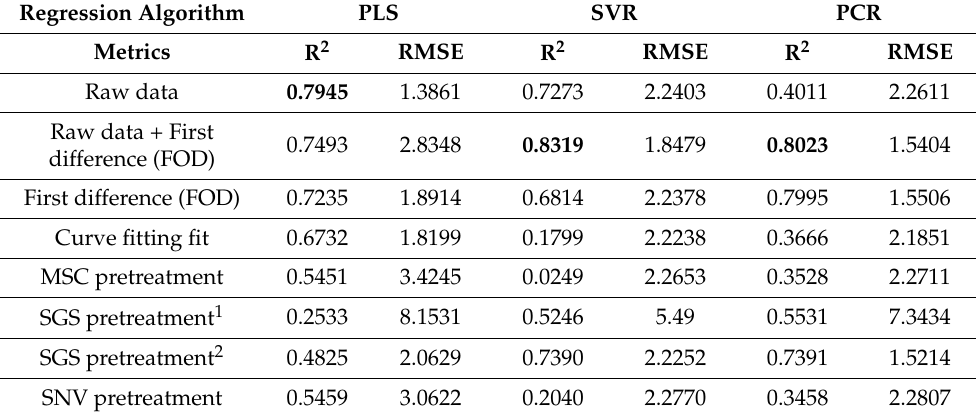
Table 1. Comparison of hyperspectral data and root length prediction for corn seeds. Regression